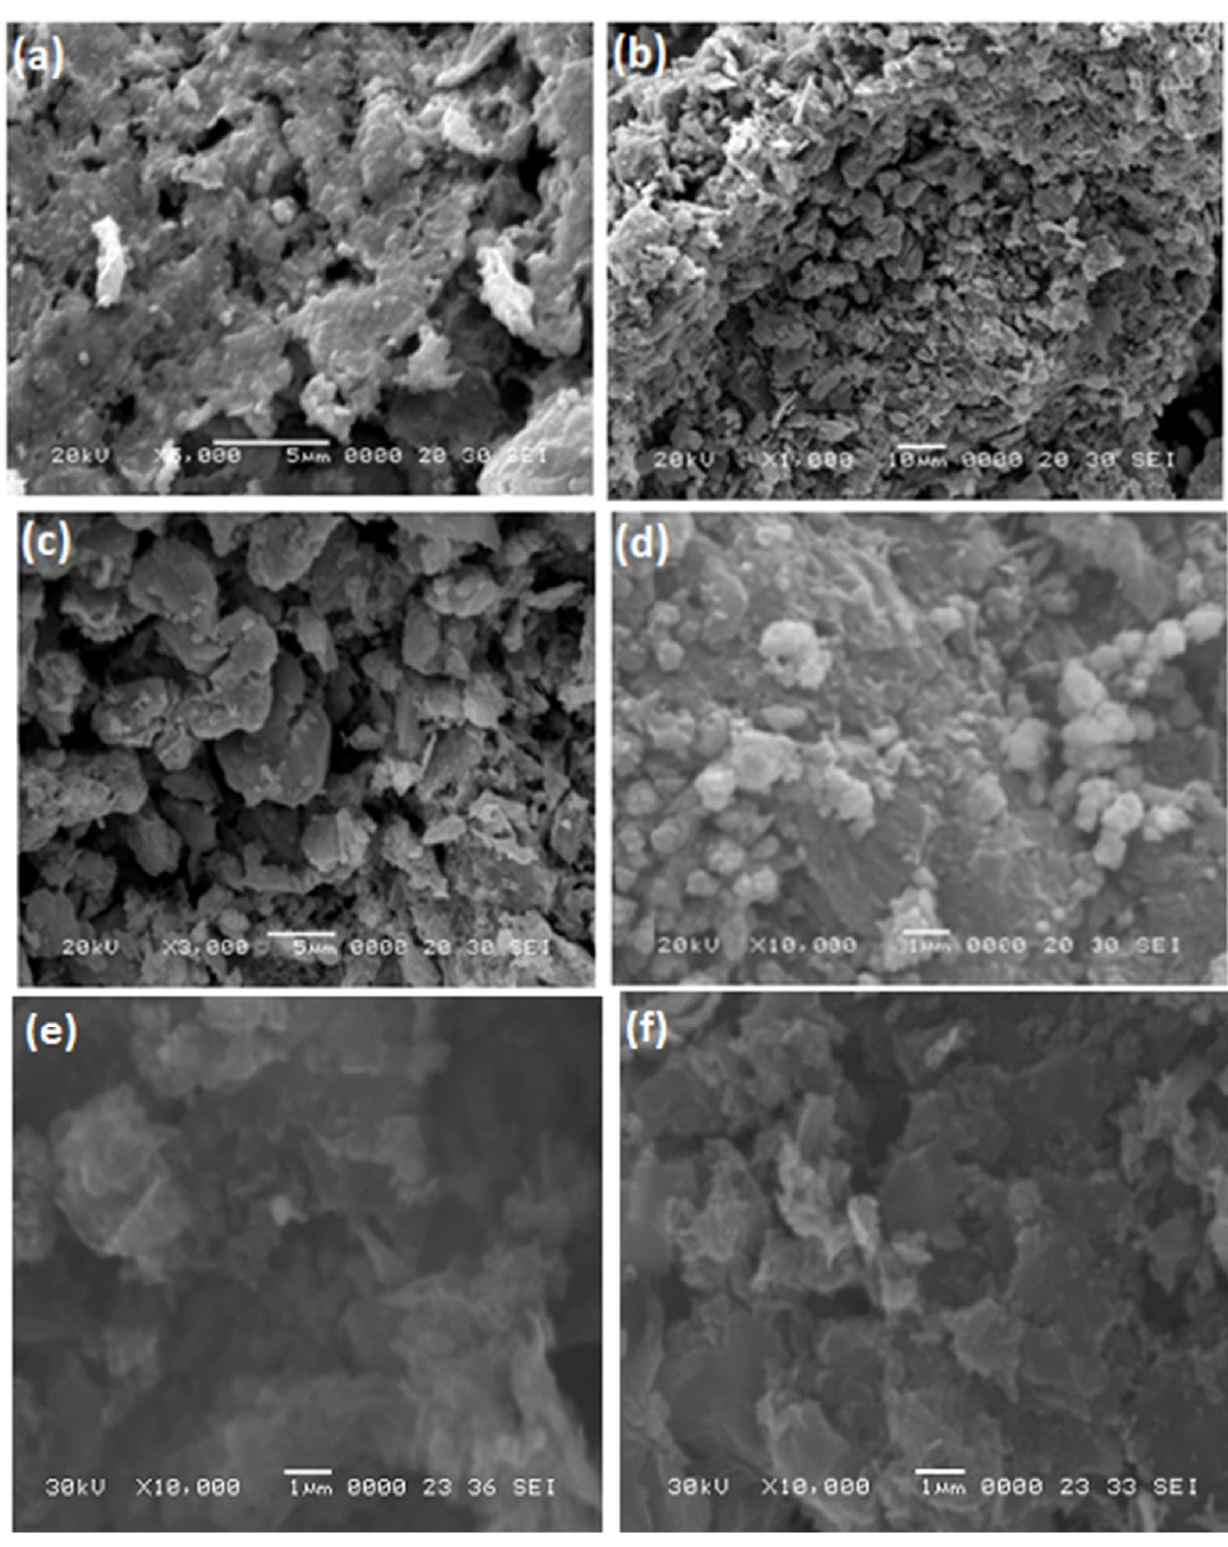
Figure 3. FESEM ( a – d ) images of GO and FG after CVD treatment. ( e , f ) Degraded sample.